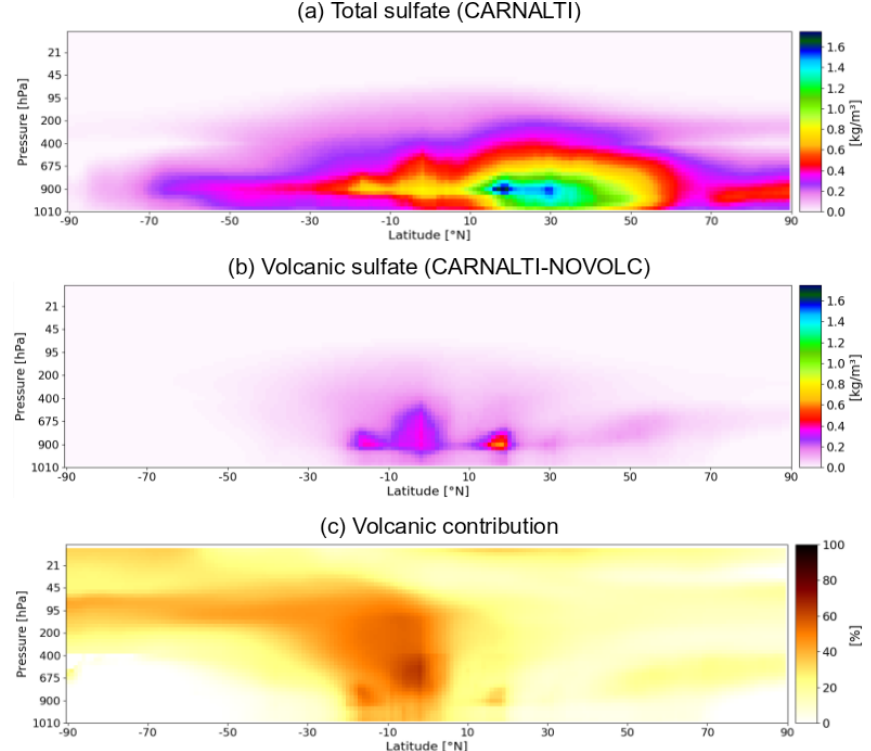
Figure 9. The 2013 annual zonal mean (a) total sulfate concentration (in kilograms per cubic meter, hereafter kgm − 3 ), (b) volcanic sulfate concentration (in kgm − 3 ) and (c) volcanic sulfate contribution (in